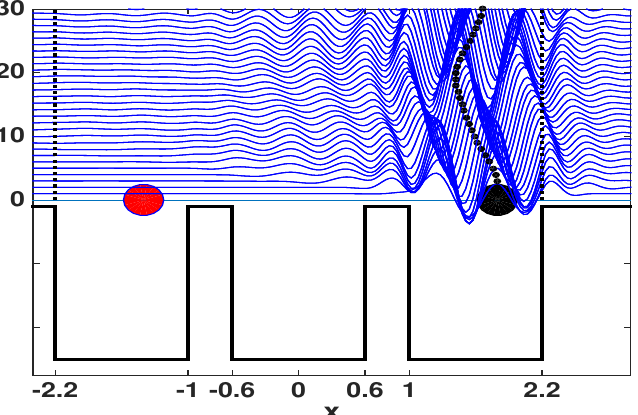
Figure 4. This is a schematic representation of our domain with 3 cavities, all of width 1.2 cm and depth 0.5 cm. The vertical axis represents time in terms of Faraday periods T F . Each wave trace is depicted in a Faraday period, namely, at t = n · T F , n integer. Two barriers (of width 0.4 cm) separate the cavities. The fluid depth above the barrier is small, so that the droplets are confined to their initial cavities. The small dots indicate the droplet’s orbit in time. A small amplitude surface wave is transmitted to the left, over the barrier. There is very little wave-activity in the mid-cavity and no activity in the left cavity. Eventually a second droplet will be placed in the left-most cavity, as indicated by the dot at